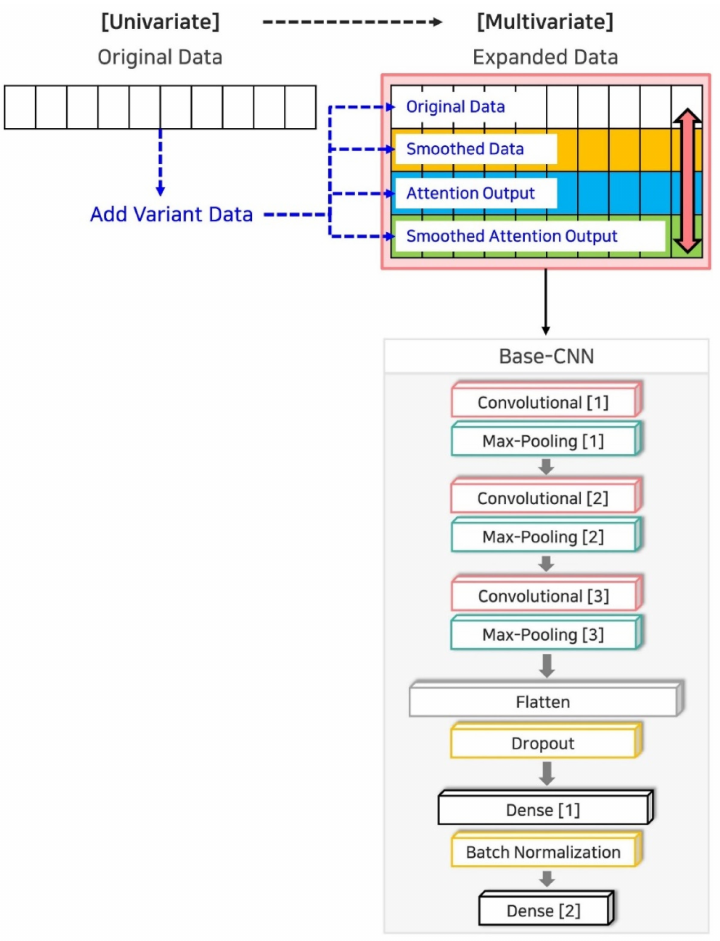
Figure 5. Expansion from univariate to multivariate by adding variants. Added variants, such as smoothed data, attention output, and smoothed attention output, are generated from the original